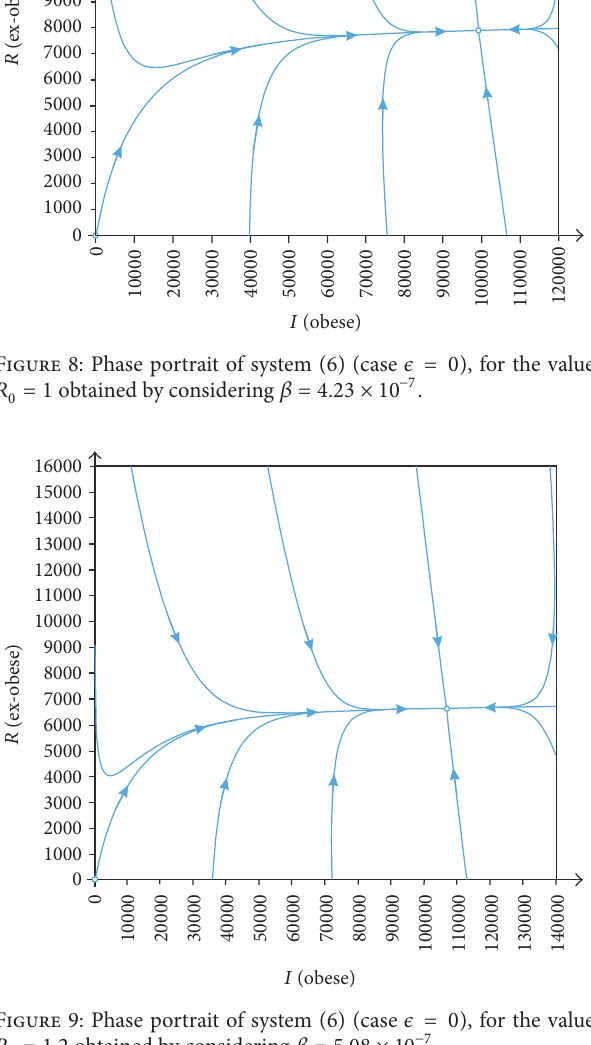
Figure 9: Phase portrait of system (6) (case 𝜖 = 0 ), for the value = 1.2 obtained by considering 𝛽 = 5.08 × 10 −7 𝑅 0